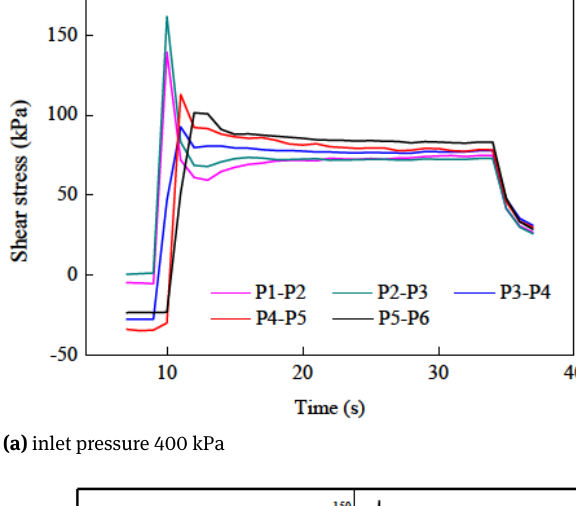
data under 400 kPa, the time required for pipe to restart under 150 kPa is much